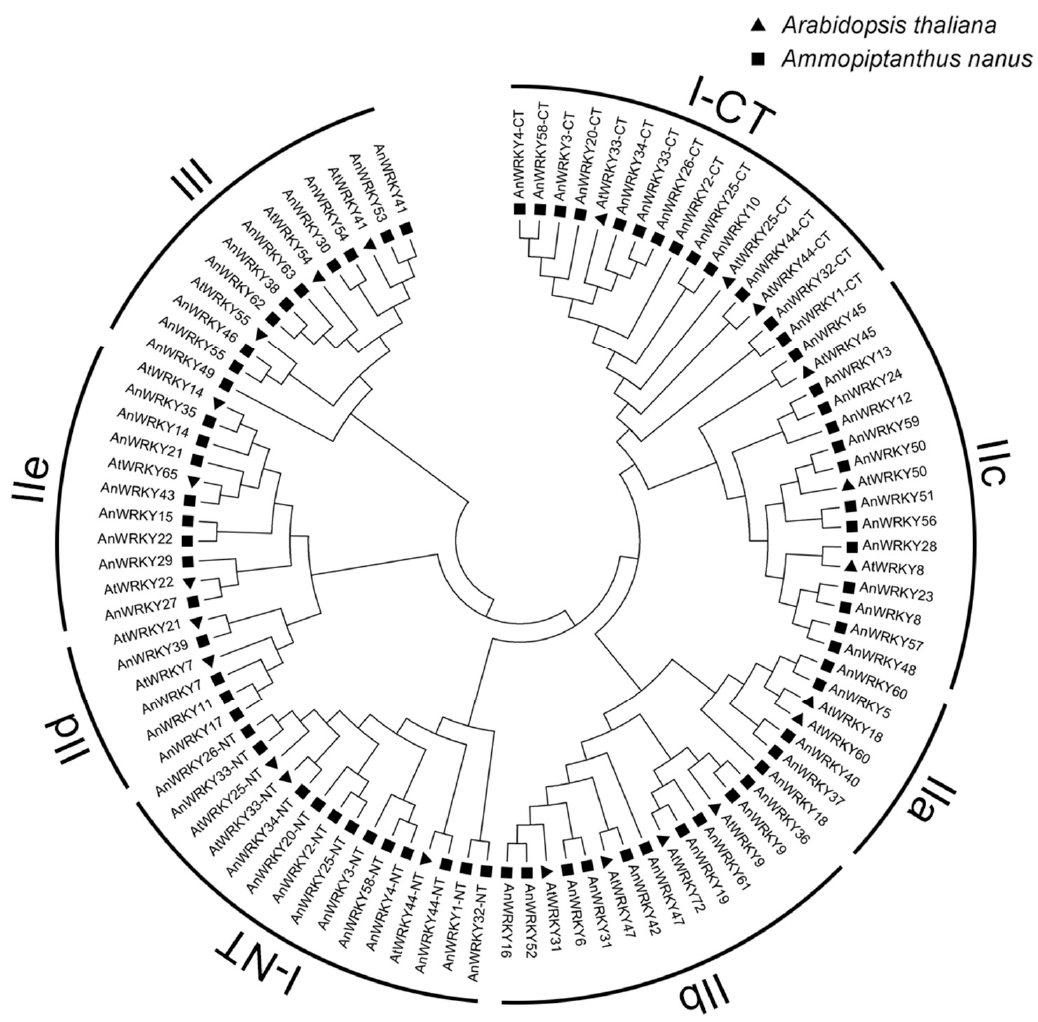
Figure 1. Phylogenetic tree of AnWRKY proteins. The tree was constructed using the neighbor-joining method, implemented in MEGA 7.0 software. The bootstrap value was 1000. Selected AtWRKY proteins serve as representatives for the different subgroups. Triangles indicate Arabidopsis WRKY proteins; squares indicate A. nanus proteins. The black intermittent arcs indicate different groups and subgroups. For group I proteins, “NT” and “CT” indicate the N-terminal and C-terminal WRKY domains, respectively.